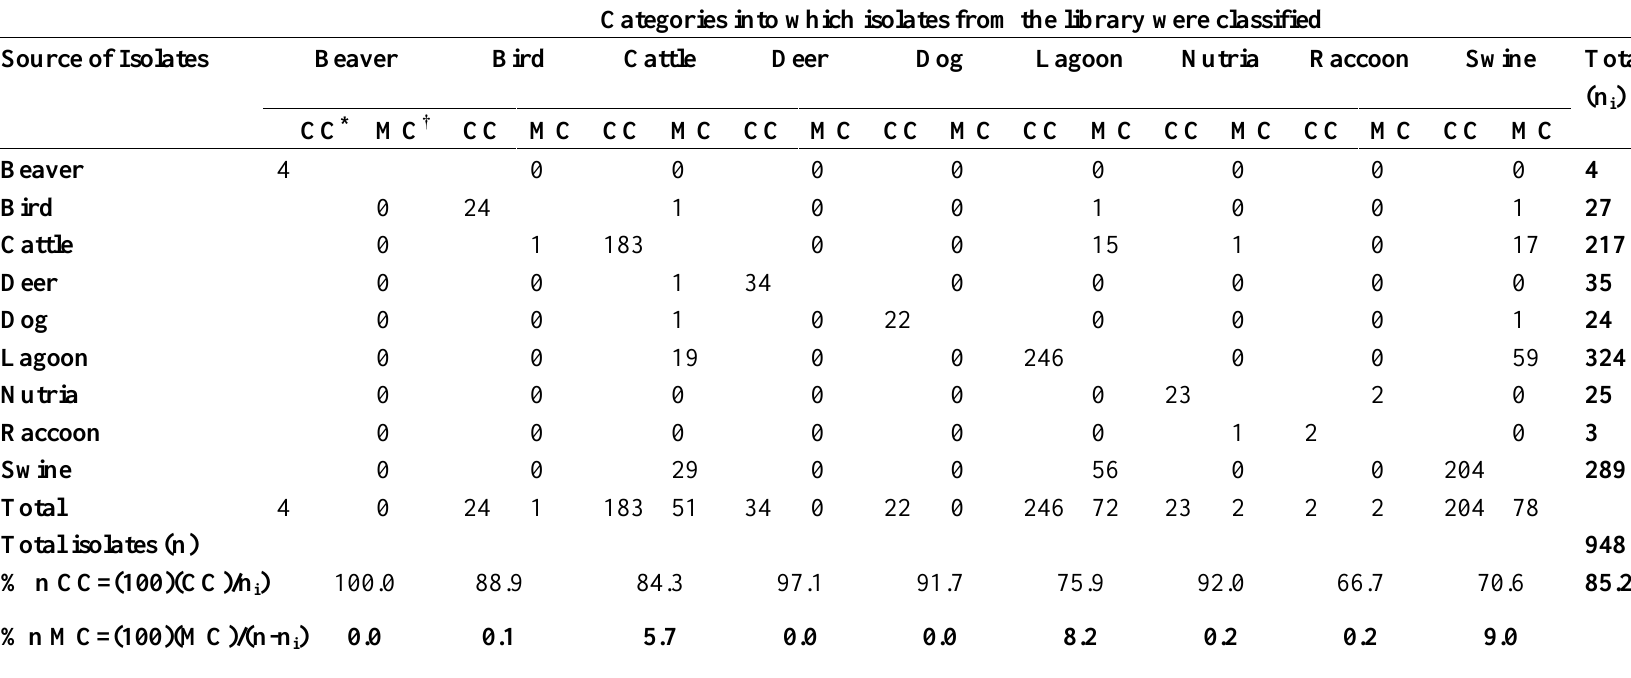
Table 2. Discriminant analysis of unique antibiotic resistance patterns (ARPs) used to classify E. coli from nine known sources into source categories. Categories into which isolates from the library were classified Source of Isolates Beaver Bird Cattle Deer Nutria